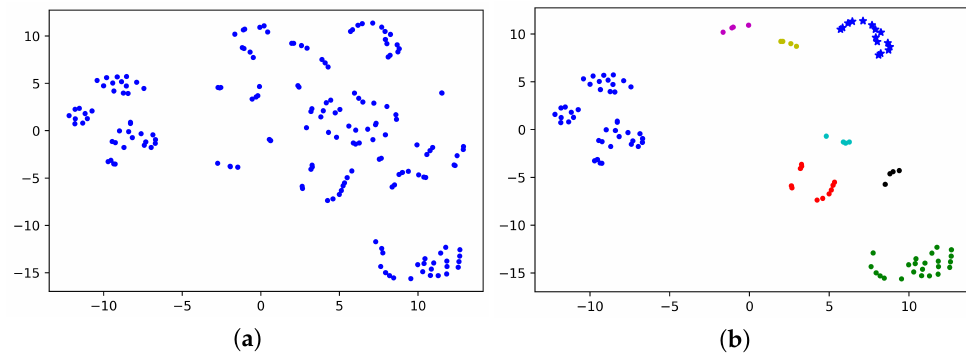
Figure 6. ( a ) Differential frame distribution. ( b ) Distribution after